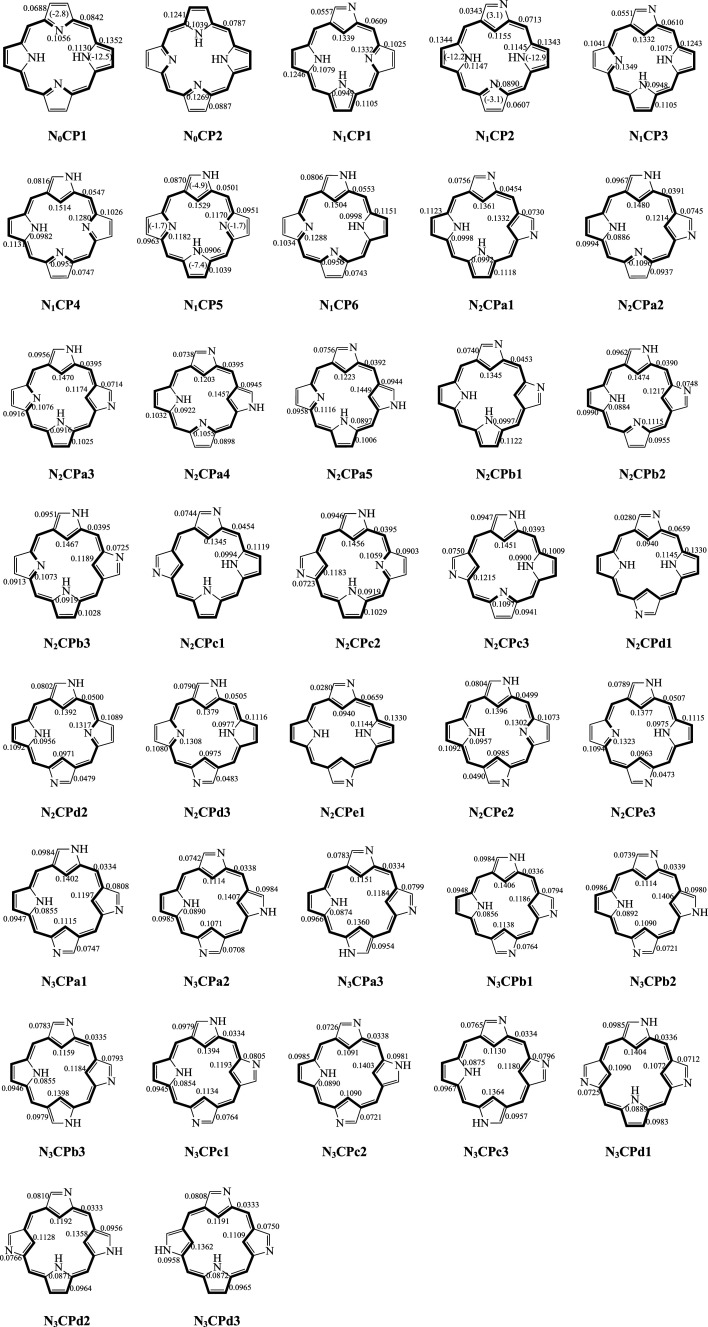
The structures of the NCPs in this study. The BRE values are in units of |β| for all π bonds. The main aromatic conjugation pathways are shown in bold. The NICS(0) values for the individual rings of N0CP1, N1CP2 and N1CP5 are given in parentheses. These values are taken from reference [54].